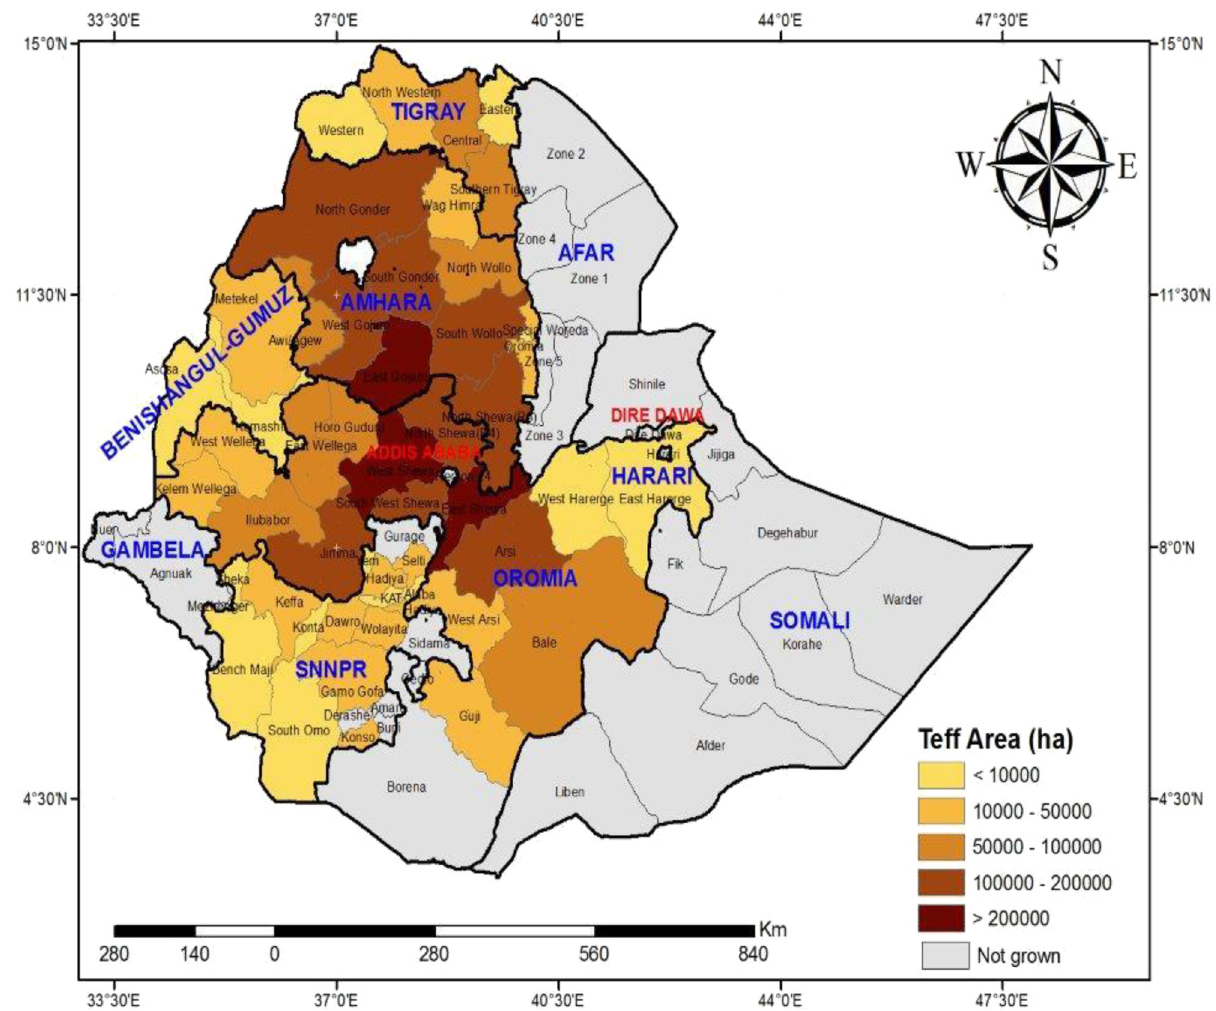
Figure 1: Map of major te ff producing areas of Ethiopia. Source: Yumba et al. ( 2014 )